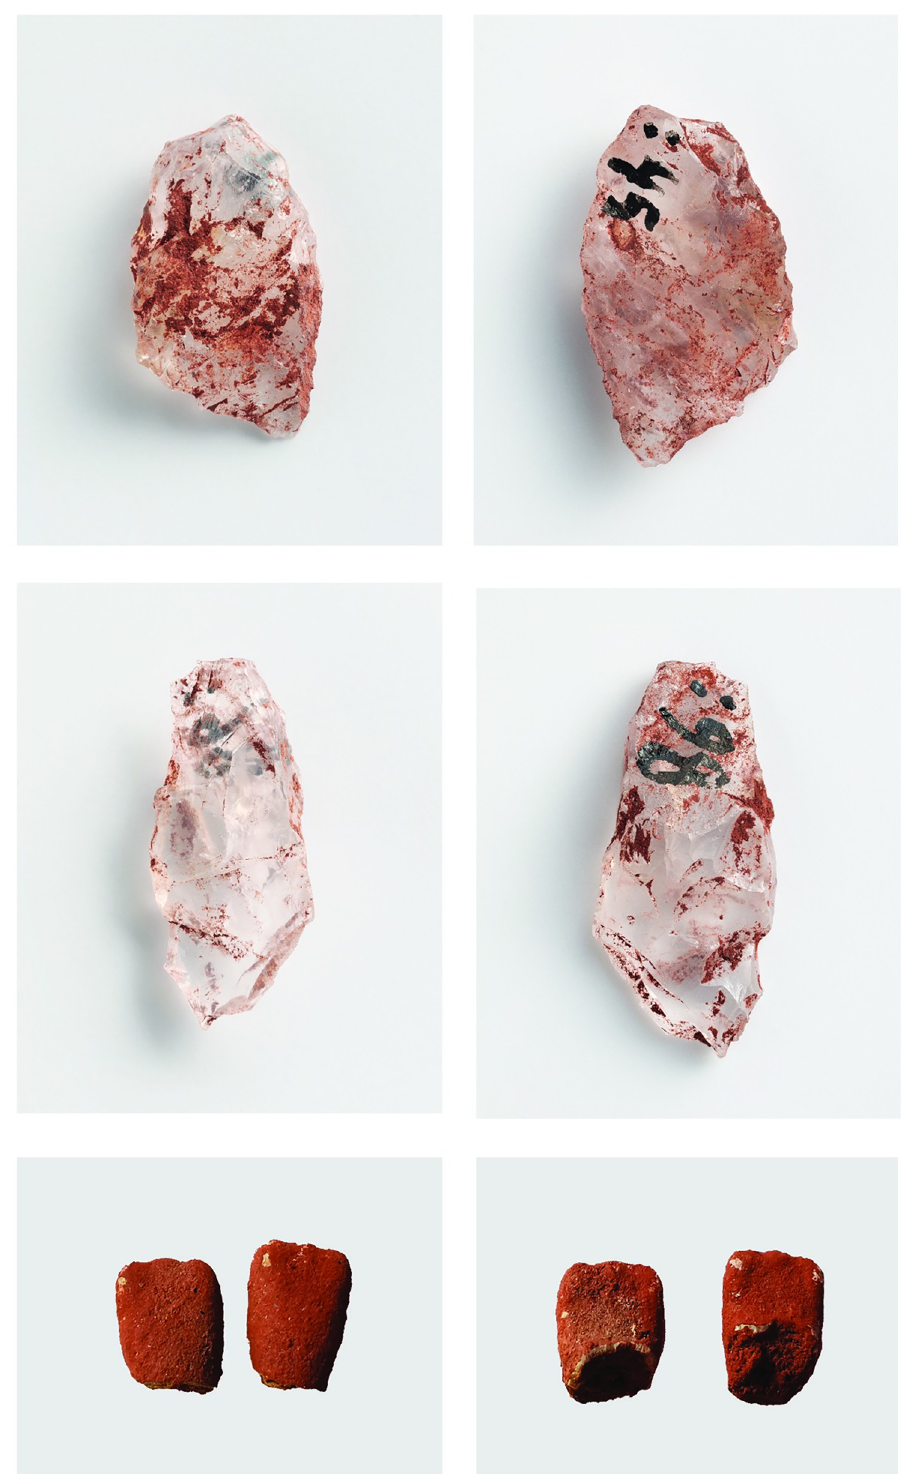
Fig 3. The find material of the grave: Transverse arrowheads abobe: 13x8x3 mm (KM 41572:45), and middle: 15x7x3 mm (:98). Below: Two permanent mandibular incisors (KM 41572:47); Photos Ilari Ja¨rvinen / Finnish Heritage Agency, Archaeological collections and Kristiina